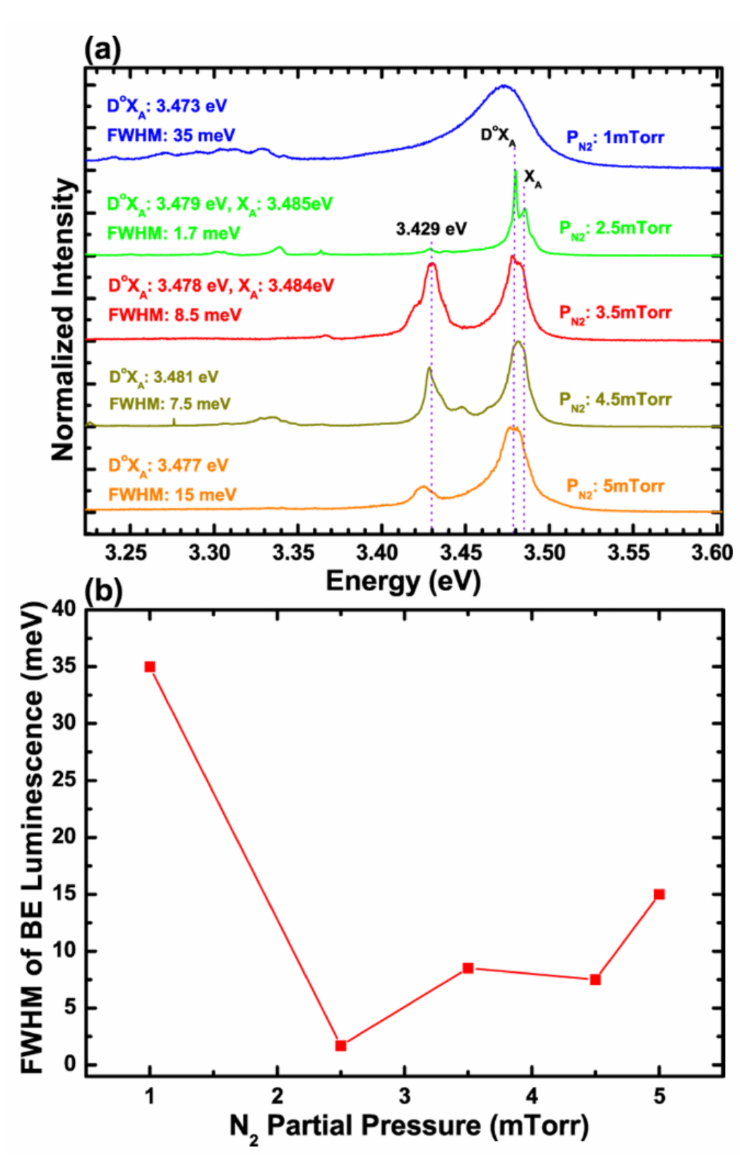
Figure 5. ( a ) µ -PL Spectra from GaN nanorods grown at different nitrogen partial pressures and ( b ) full-width-at-half-maximum (FWHM) of band-edge luminescence vs. nitrogen partial